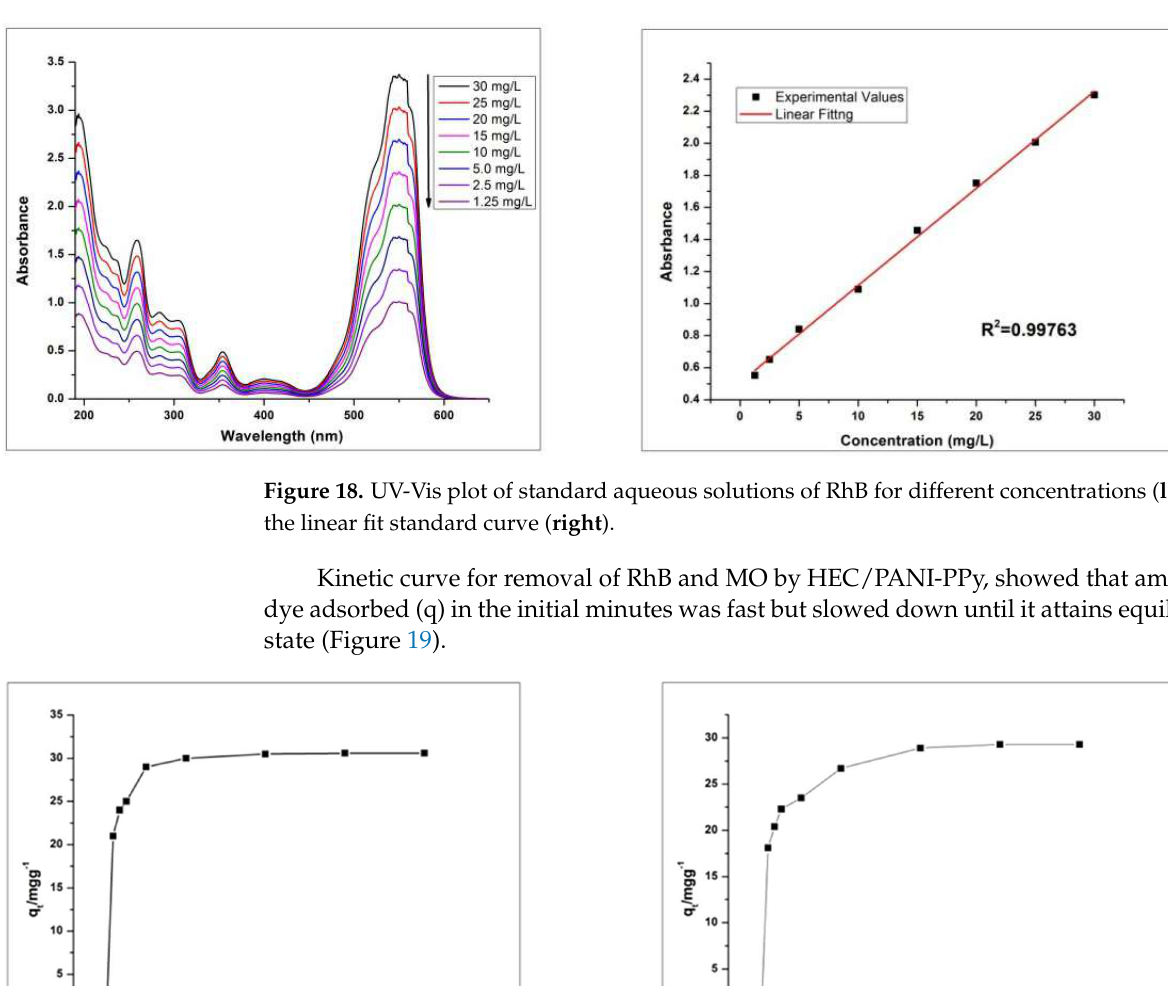
Figure 17. UV-Vis plot of standard aqueous solutions of MO for different concentrations ( left ) and the linear fit standard curve ( right ).